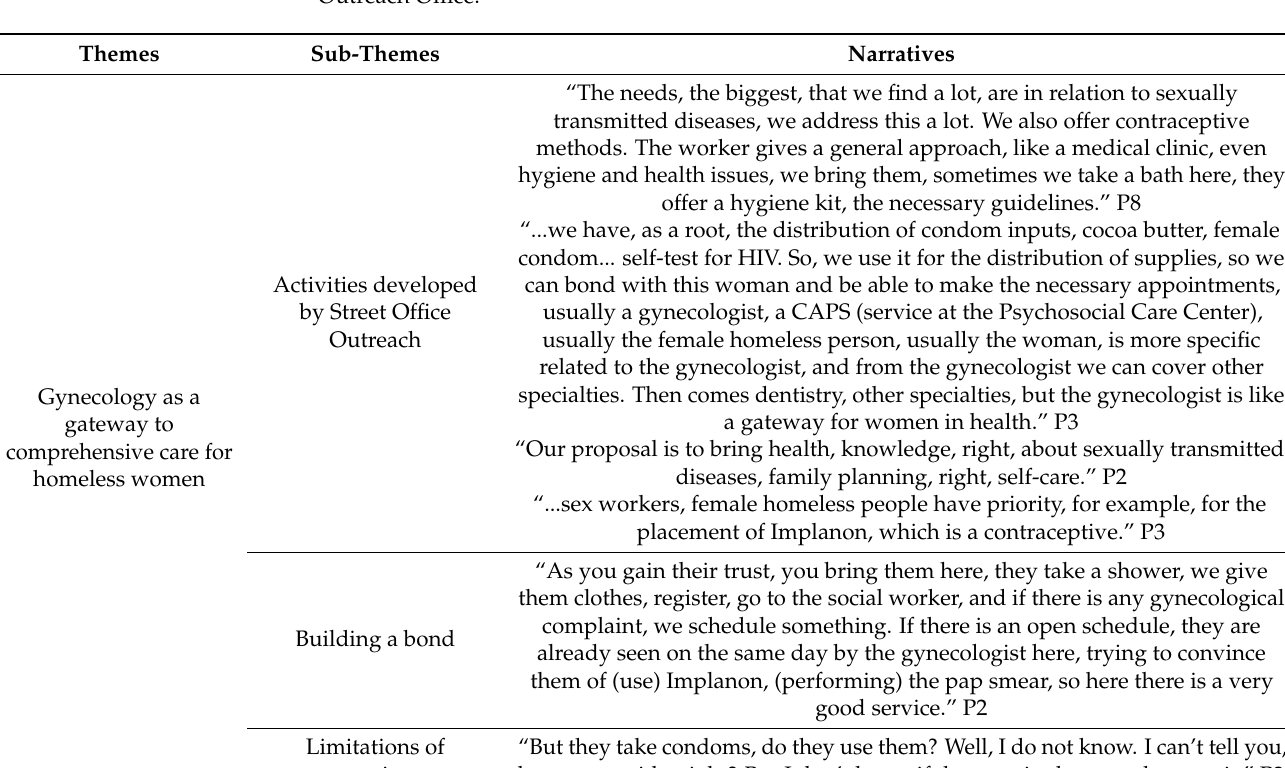
Table 2. Some workers’ narratives related to homeless women’s care developed in a Brazilian Street Outreach Office.